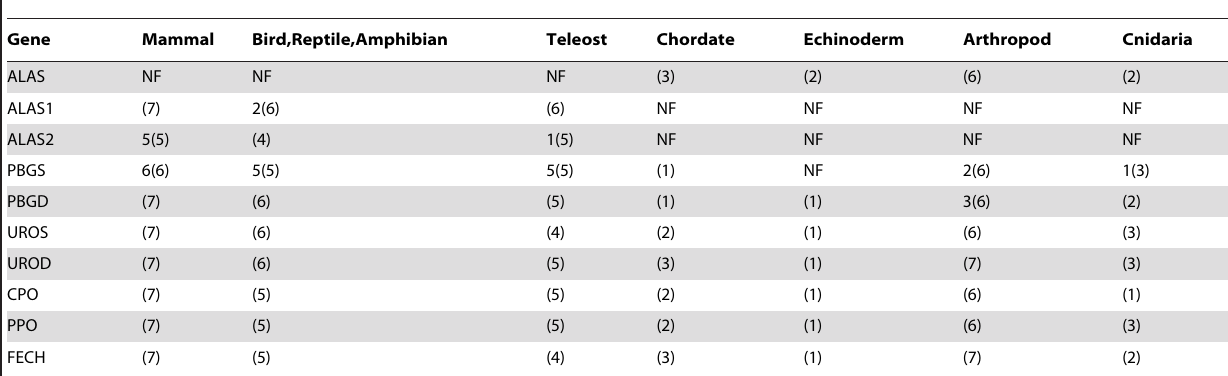
Table 7. HRM_r in protein sequence.